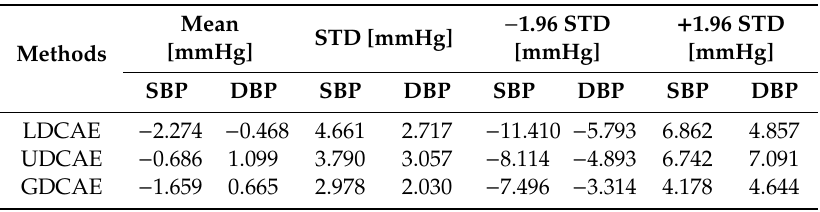
Table 4. Bland–Altman DCAE Model